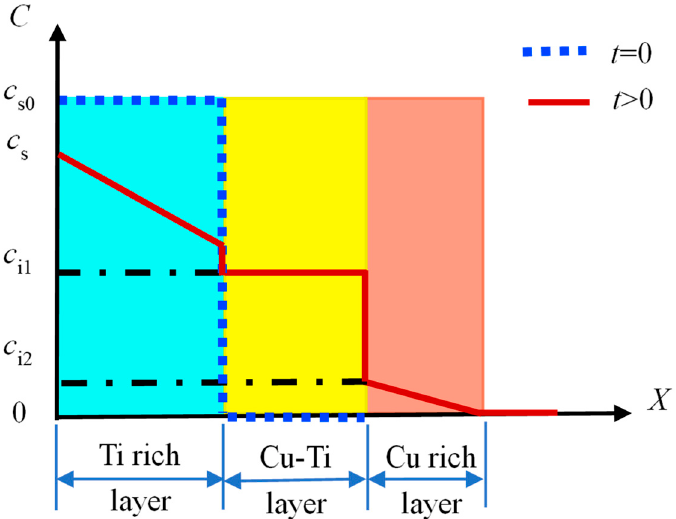
Figure 1. Schematic illustration of the cross-sectional profile for the multi-phase coating.